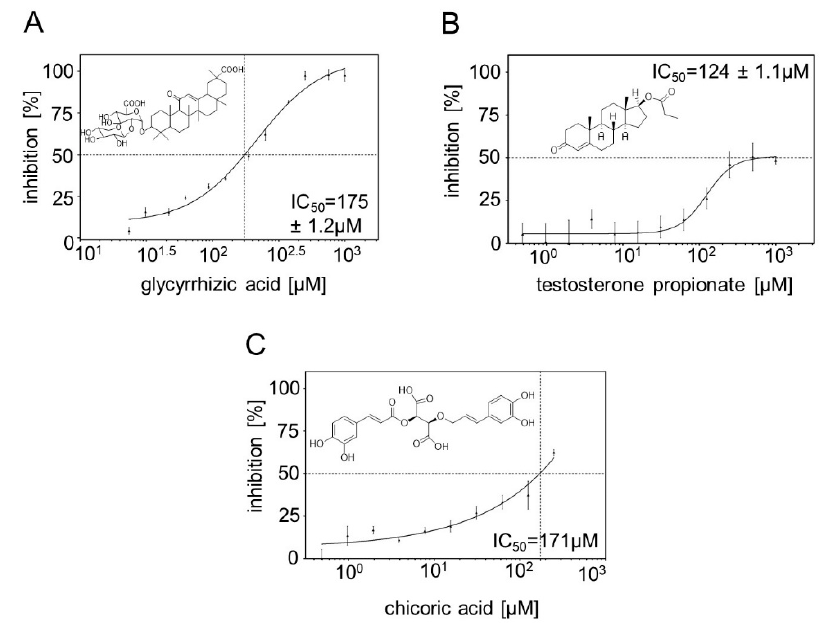
Figure 10. IC 50 curves of glycyrrhizic acid ( A ), testosterone propionate ( B ) and chicoric acid ( C ). Inhibition of Hyal1 was tested using 12 di ff erent concentrations of testosterone propionate and glycyrrhizic acid and 10 di ff erent chicoric acid concentrations. The horizontal dotted line marks represent 50% inhibition. The vertical dotted line marks represent the inhibitor concentration at 50% inhibition. IC 50 value of 175 ± 1.2 µ M for glycyrrhizic acid, 124 ± 1.1 µ M for testosterone propionate and 171 µ M for chicoric acid were determined. Mean values ± SD are given (n = 3). Because of the incomplete course of the curve obtained for chicoric acid, no SD could be calculated.